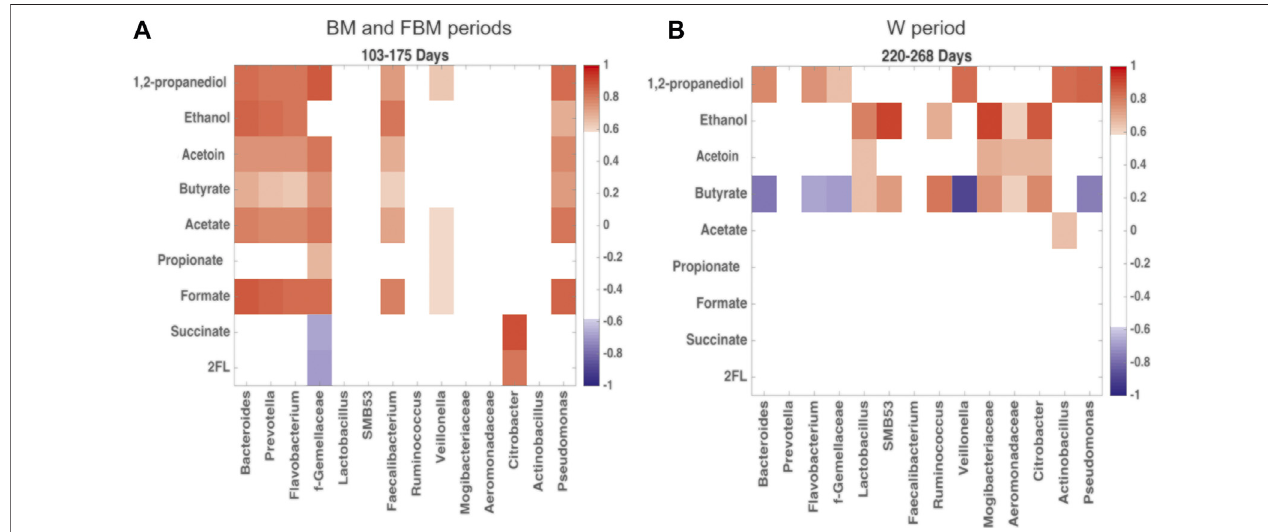
FIGURE 7 | Heatmap built from Pearson ’ s correlation coef fi cients for the microbial metabolic products of carbohydrate degradation and OTUs. Comparison between (A) days 103 – 175, predominantly breastfeeding, and (B) days 220 – 268, predominantly solid food. Red: positive correlations; blue: negative correlations. Correlation coef fi cient > 0.6 and < − 0.6 are signi fi cant with p < 0.05. Only OTUs with signi fi cant correlation coef fi cient for carbohydrate degradation products were reported in fi gure.